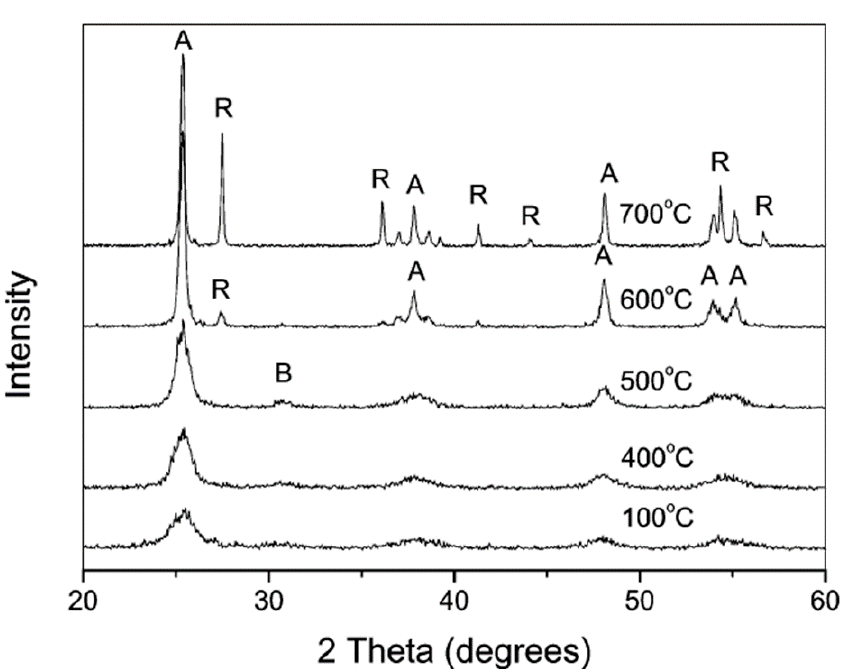
Figure 8. Evolution of the XRD pattern of a TiO 2 sample peptized with HNO 3 and calcined at different temperatures, from [91]. The A, B, and R labels stand for anatase, brookite, and rutile phases, respectively (reproduced with permission from J. Yu et al., Journal of Catalysis; published by Elsevier, 2003).